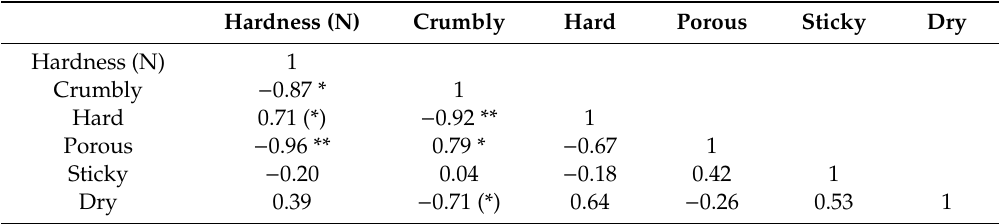
Table 4. Pearson correlation coe ffi cients among texture attribute perception and hardness measured by instrumental analysis (N).